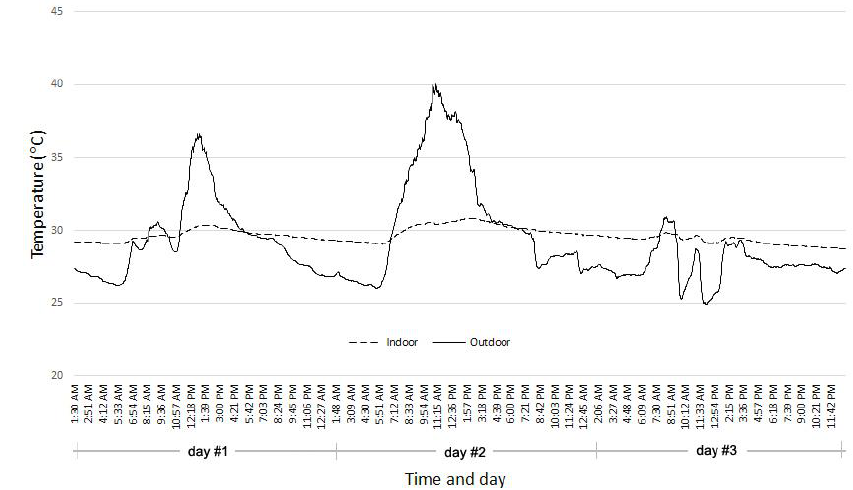
Fig. 12. Outdoors and indoors temperature recorded of A